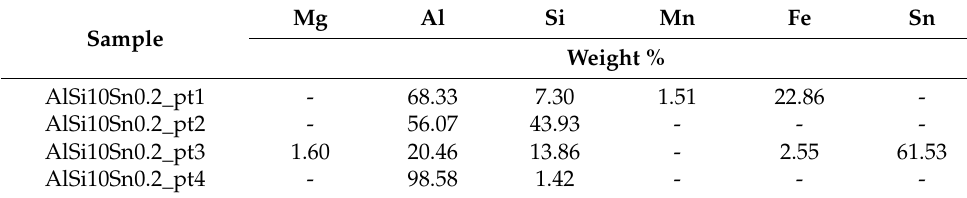
Figure 13. SEM-EDS analysis of microstructure and chemical composition of Si10Sn1.7 alloy (element distribution map—mag. 1000 × ): ( a ) image of microstructure; ( b ) Al; ( c ) Si; ( d ) Sn. Table 6. Chemical composition of AlSi10Sn0.2 alloy in micro area from Figure 11.